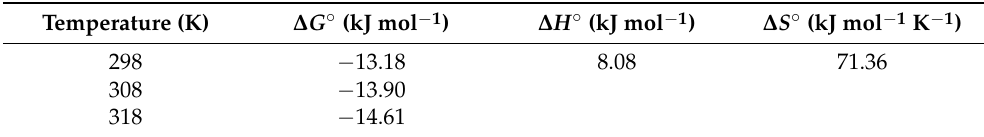
Table 5. Thermodynamic parameters for CFA adsorption onto NR/WMS-0.05 at different tempera-